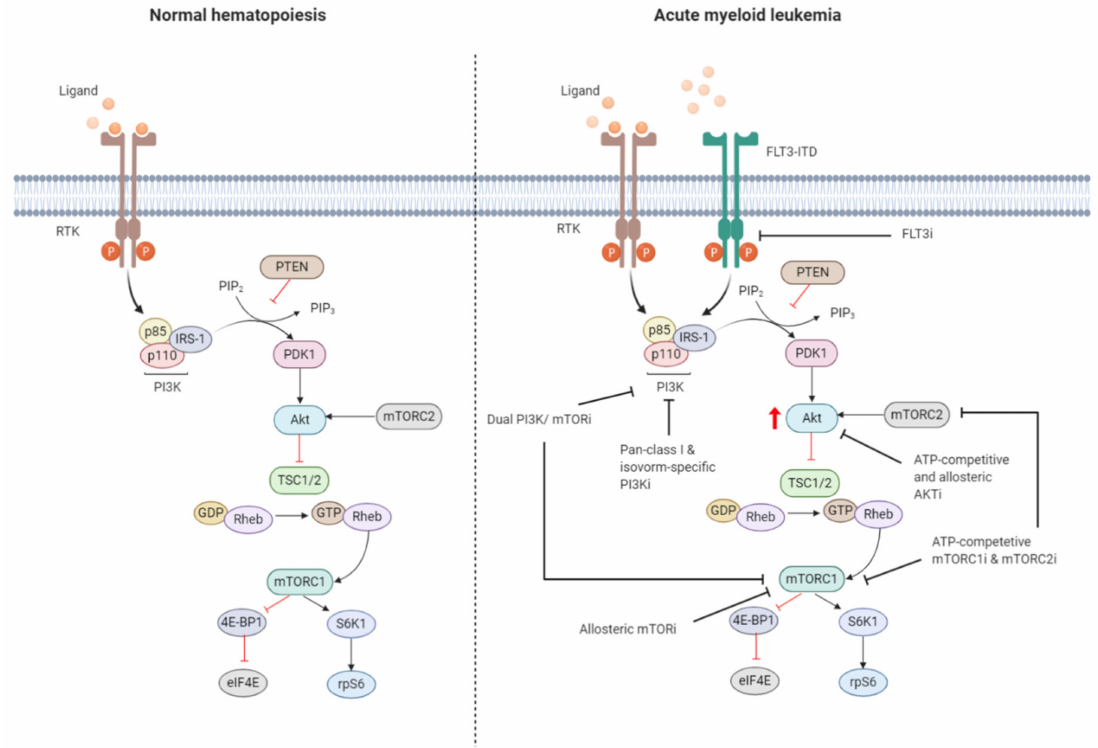
Figure 3. Targeting the PI3K / Akt / mTOR pathway in AML. The PI3K / Akt / mTOR pathway is commonly dysregulated in AML caused by mutations in membrane-bound proteins such as receptor tyrosine kinases (RTKs) and small GTPase Ras. Activating mutations in fms-like tyrosine kinase 3 (FLT3), such as the FLT3-internal tandem duplication (FLT3-ITD), are an important mechanism leading to dysregulation of PI3K / Akt / mTOR signaling. The ITD mutation causes ligand-independent activation of the FLT3 receptor, leading to constitutive activation of the PI3K / Akt / mTOR pathway. Numerous small-molecule inhibitors of this pathway include FLT3 inhibitors (FLT3i), dual PI3K / mTORi, allosteric mTORi, pan-class I and isoform-specific PI3Ki, ATP-competitive and allosteric Akti, and ATP-competitive mTOR complex 1 (mTORC1) and mTOR complex 2 (mTORC2) inhibitors (mTORC1i and mTORC2i). The red arrow indicates elevated Akt phosphorylation, whereas the red blunt-ended lines represent negative regulation (inhibition). IRS-1 = insulin receptor substrate 1, PIP 2 = phosphatidylinositol-4,5-phosphate, PIP 3 = phosphatidylinositol-3,4,5-phosphate, PTEN = phosphatase and tensin homolog, PDK1 = phosphoinositide-dependent kinase-1, TSC 1 / 2 = tuberous sclerosis complex 1 / 2, ATP = adenosine triphosphate, GDP = guanosine diphosphate, GTP = guanosine triphosphate, Rheb = Ras homolog enriched in brain, 4E-BP1 = eukaryotic translation initiationfactor4E(eIF4E)-bindingprotein1, S6K1 = ribosomalproteinS6kinasebeta-1, rpS6 = ribosomal protein S6. The black blunt-ended lines indicate the main targets for therapeutic intervention. Created with